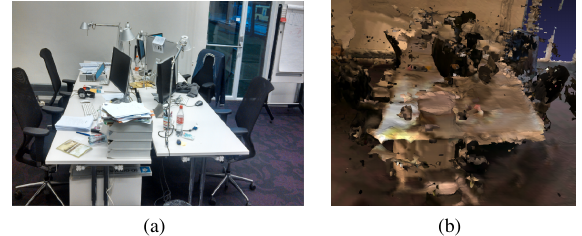
Figure 4: Cluttered desks. (a) Picture of the real scene. (b) Mesh generated by the Tango.